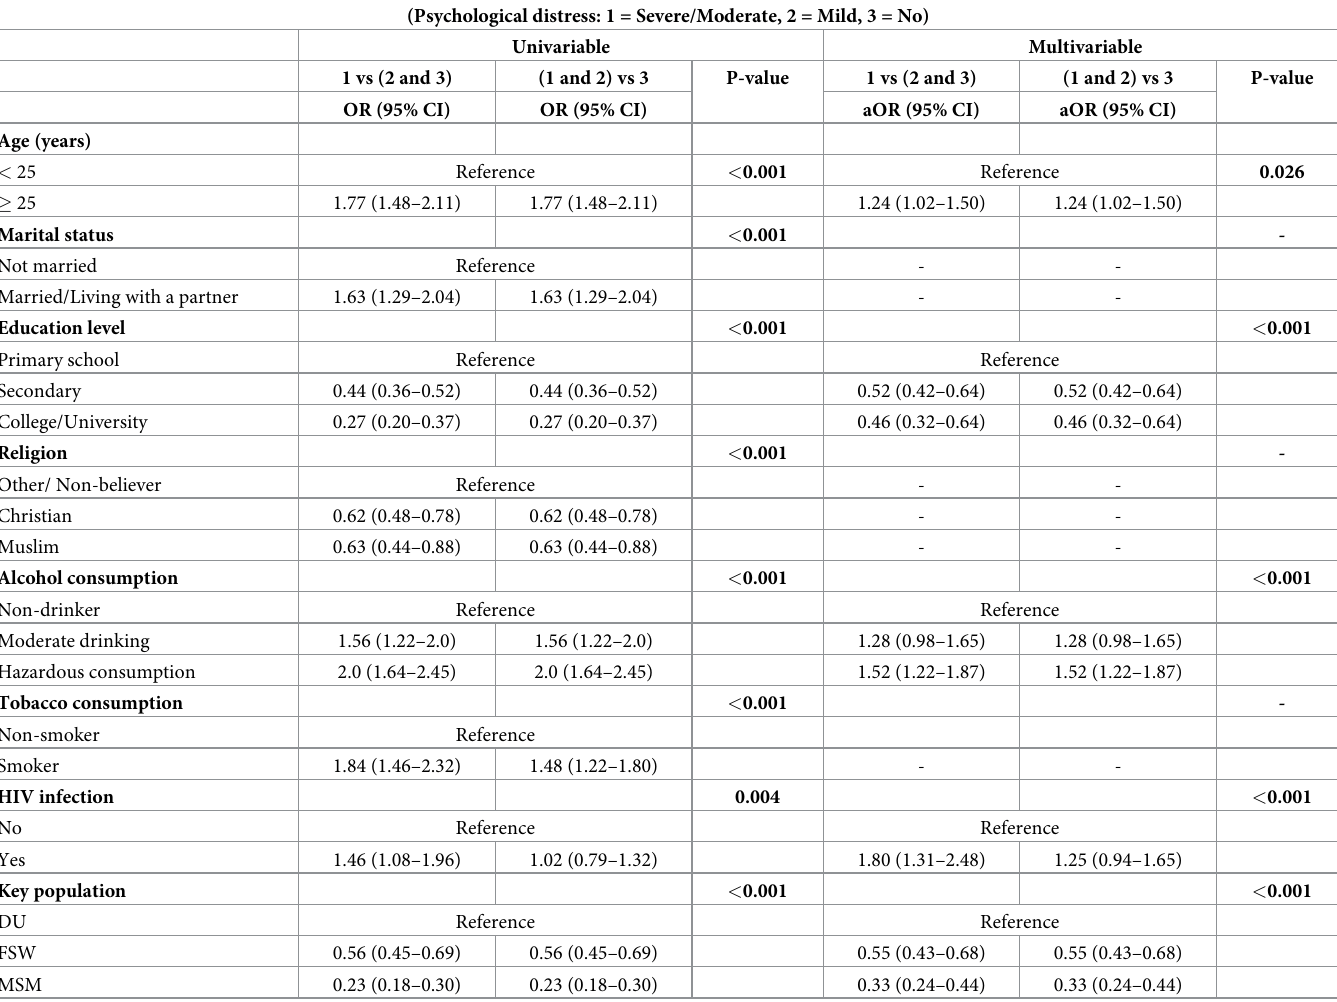
Table 3. Factors associated with psychological distress among key population in Togo (Partial proportional odds model # ). (Psychological distress: 1 = Severe/Moderate, 2 = Mild, 3 =